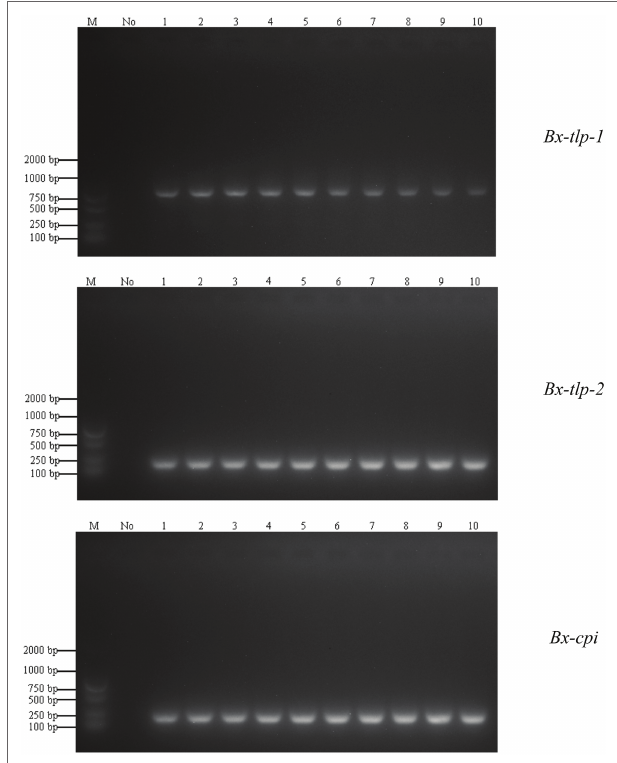
FIGURE 3 | Specificity of the PCR primers for the genes encoding potential molecular mimicry proteins in Bursaphelenchus xylophilus from Monochamus alternatus or M. saltuarius . M: DNA marker AL2000; No: no B. xylophilus in M. alternatus ; (1): PCR amplification results for B. xylophilus in M. alternatus from Fujian; (2): PCR amplification results for B. xylophilus in M. alternatus from Anhui; (3): PCR amplification results for B. xylophilus in M. alternatus from Zhejiang; (4): PCR amplification results for B. xylophilus in M. alternatus from Shandong; (5): PCR amplification results for B. xylophilus in M. alternatus from Guangdong; (6–9): PCR amplification results for B. xylophilus in M. saltuarius from Liaoning; and (10): PCR amplification results for B. xylophilus in M. saltuarius from Tianjin.